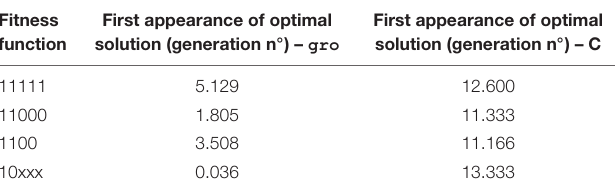
TABLE 6 | Fitness function variation for SA.